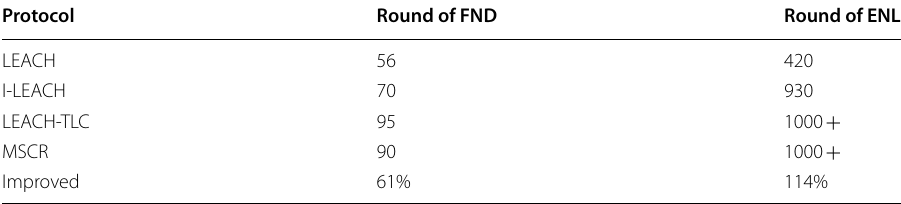
Table 2 Comparison of network